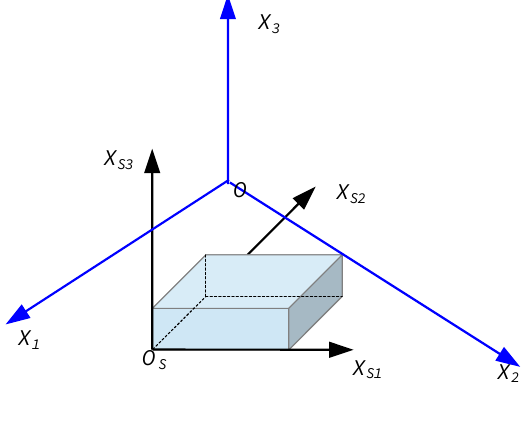
Figure 4. Relationship between the local and global